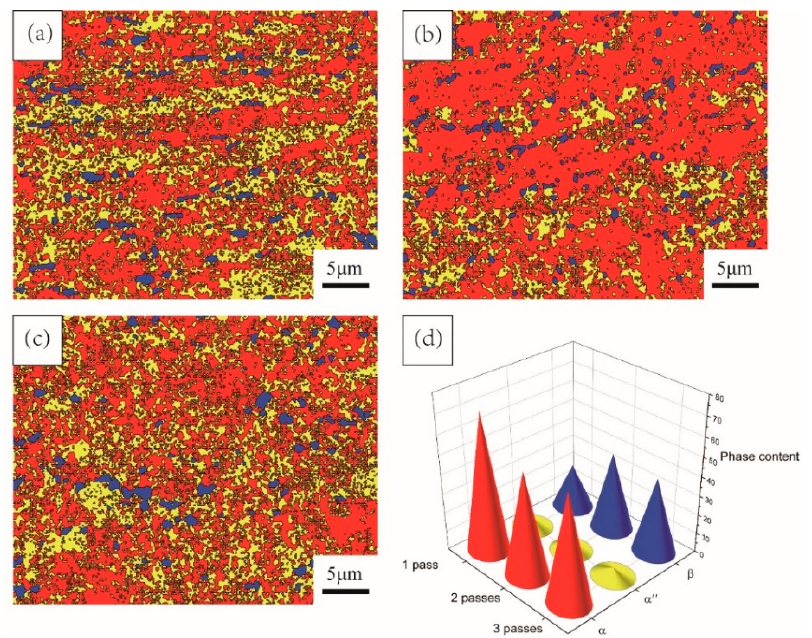
Figure 5. Phase distribution of TC4 alloy after one cycle of MDIF: ( a ) one pass; ( b ) two passes; ( c ) three passes; ( d ) statistical chart.